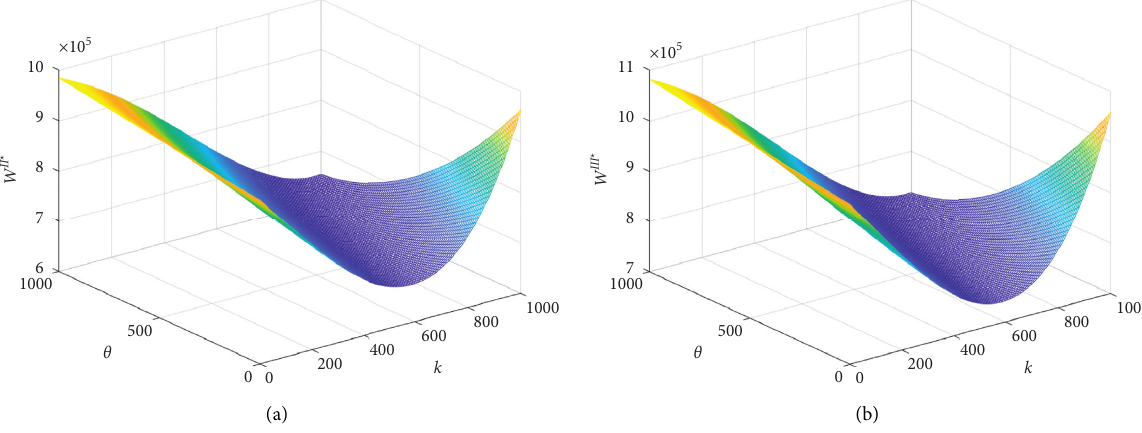
Figure 11: The effects of θ and k on profit of manufacturer. (a) W ΙΙ∗ (b) W ΙΙΙ∗ .